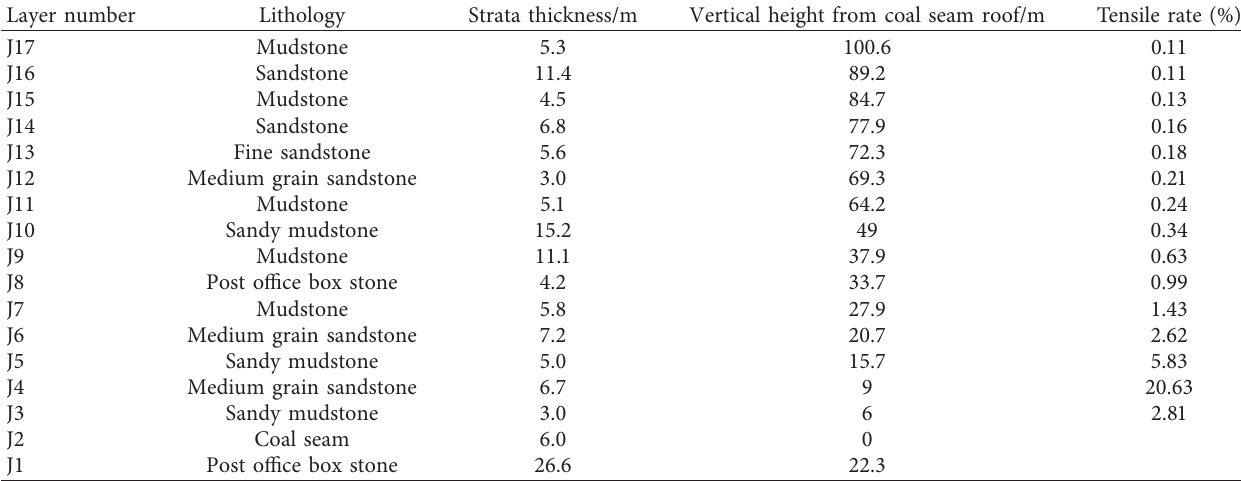
Table 1: Physical parameters and tensile rate of each rock formation.